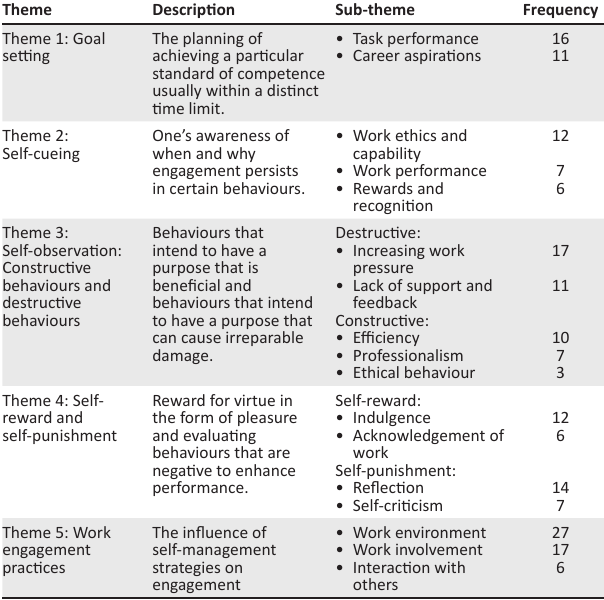
TABLE 2 : Themes and sub-themes. Theme Description Sub-theme Frequency Theme 1: Goal